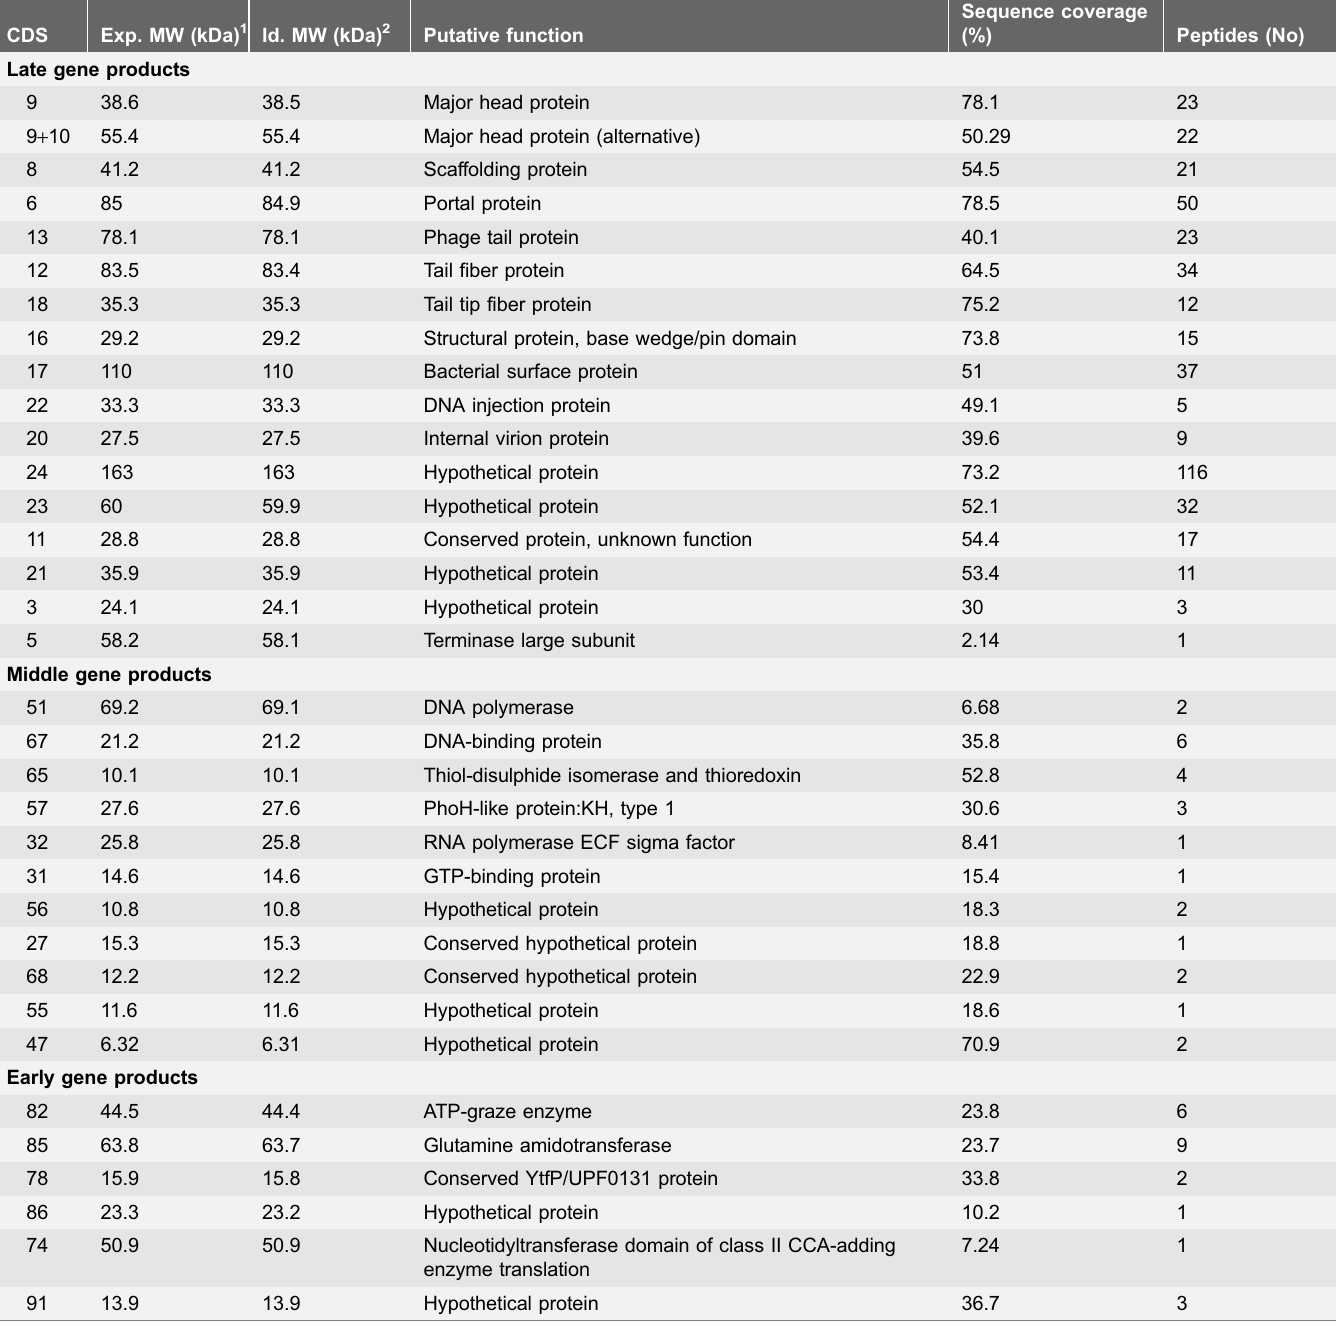
Table 2. Proteins identified by hybrid LTQ-Orbitrap Velos mass